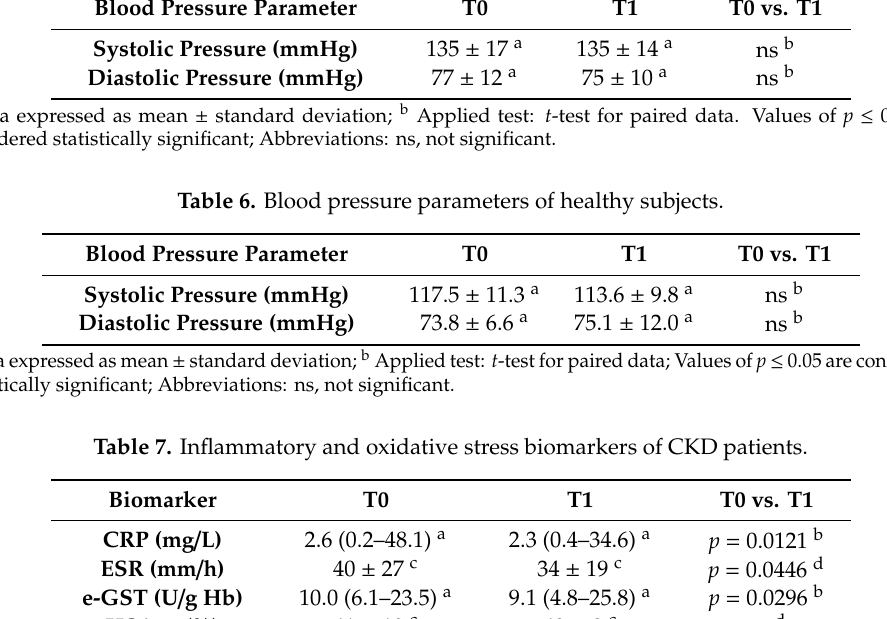
Table 5. Blood pressure parameters of CKD patients. Table 6. Blood pressure parameters of healthy subjects.